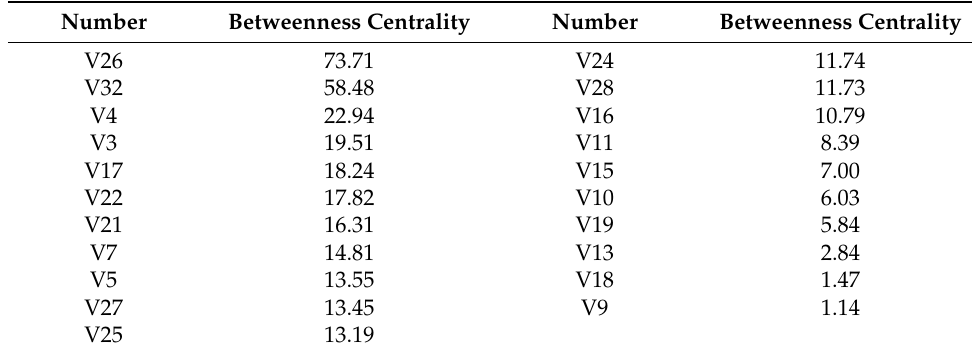
Table 9. Betweenness centrality analysis of the